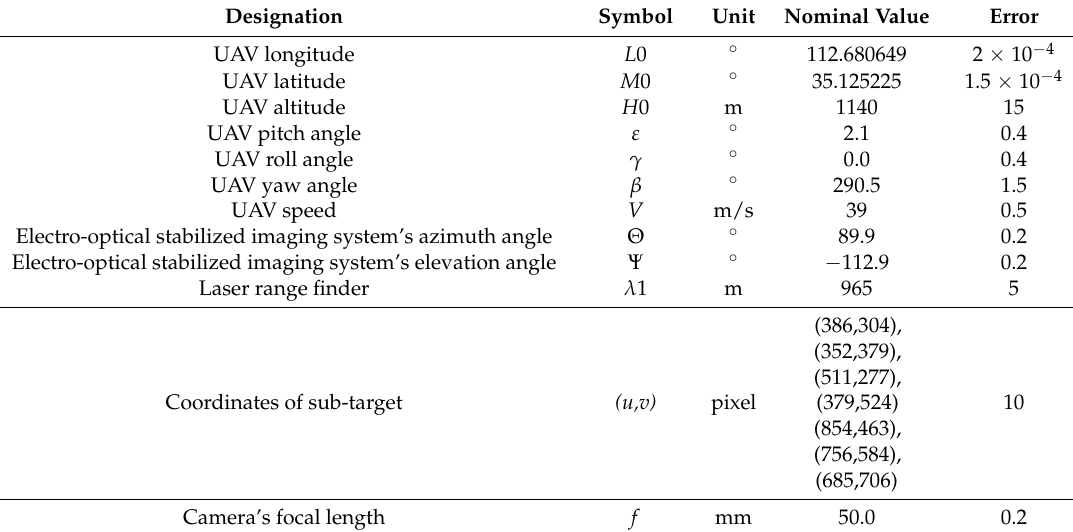
Table 1. Localization and attitude data of UAV electro-optical stabilized imaging